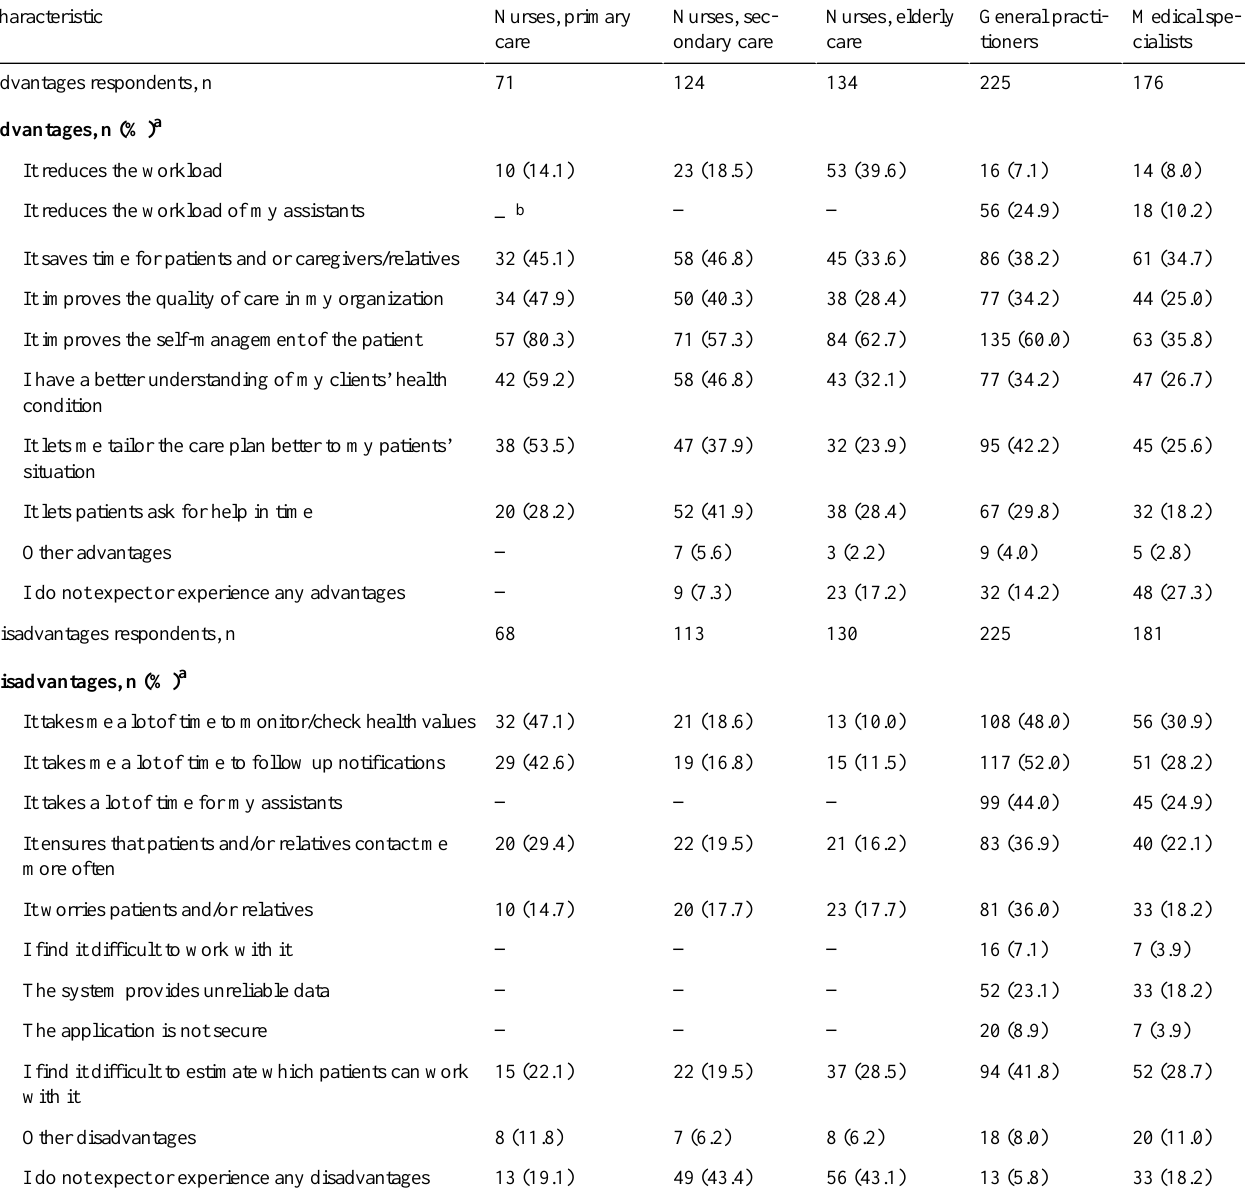
Medical spe- cialistsGeneral practi- tionersNurses, elderly careNurses, sec-